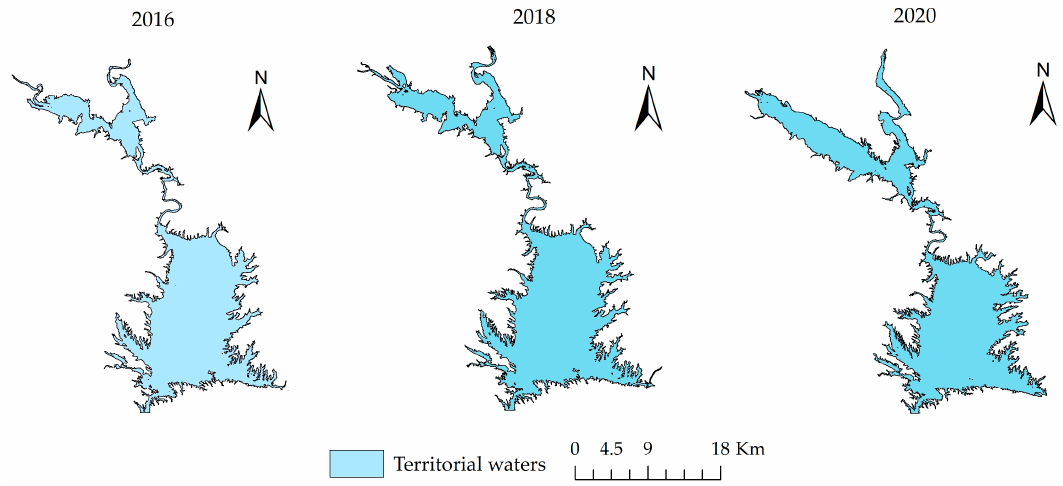
Figure 3. The water area map of the Danjiangkou Reservoir in 2016, 2018, and 2020.